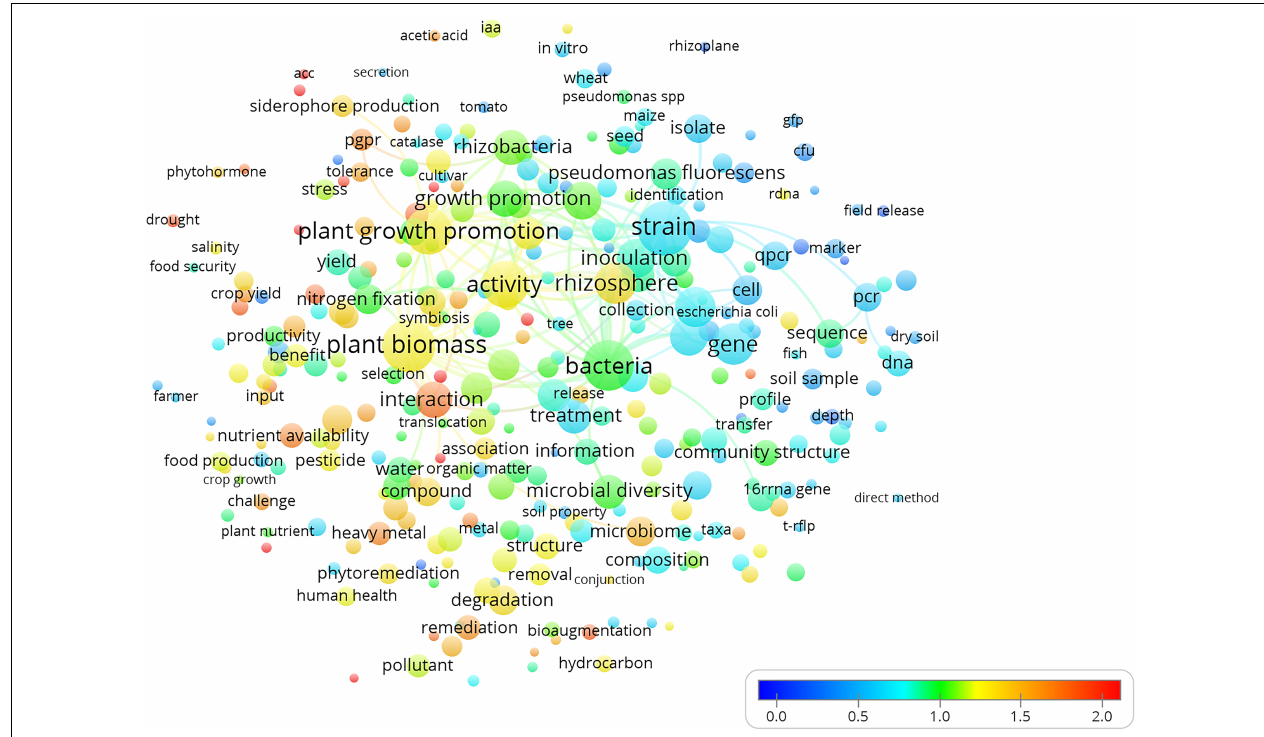
FIGURE 3 | Term map based indexed per citation rate based on all the Scopus soil microbial inoculants tracking and monitoring publications/citations. The different colors represent the normalized citation rate scale. The size of each term is based on the number of its occurrence. The connecting lines indicate the 100 strongest co-occurrence links between